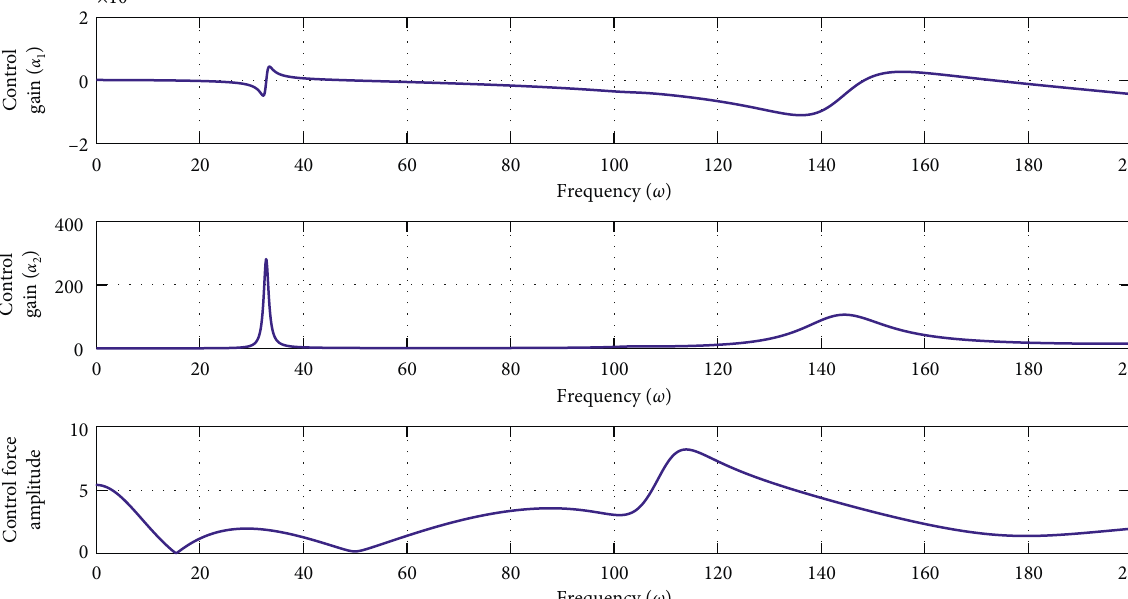
0 for the same x f , x n of the cantilever beam of Figure